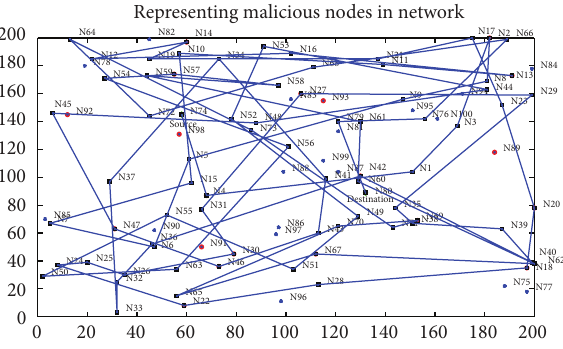
Figure 1: Representation of nodes deployed in WSN. Figure 2: Route finding based upon TSRF.